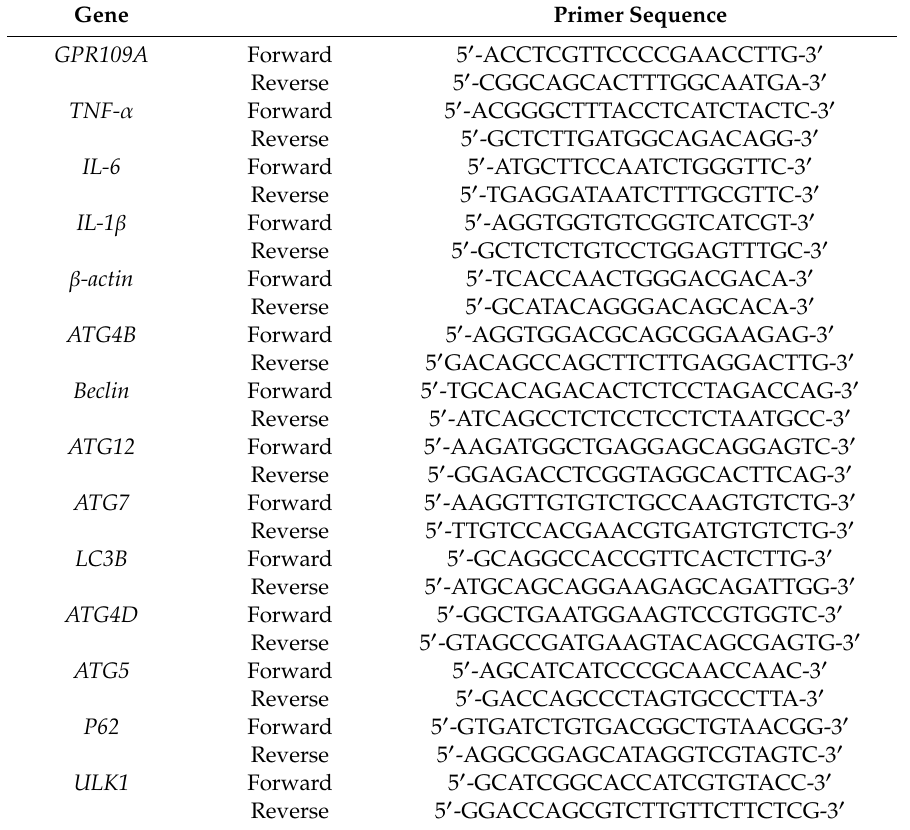
Table 1. The primer sequenceof the